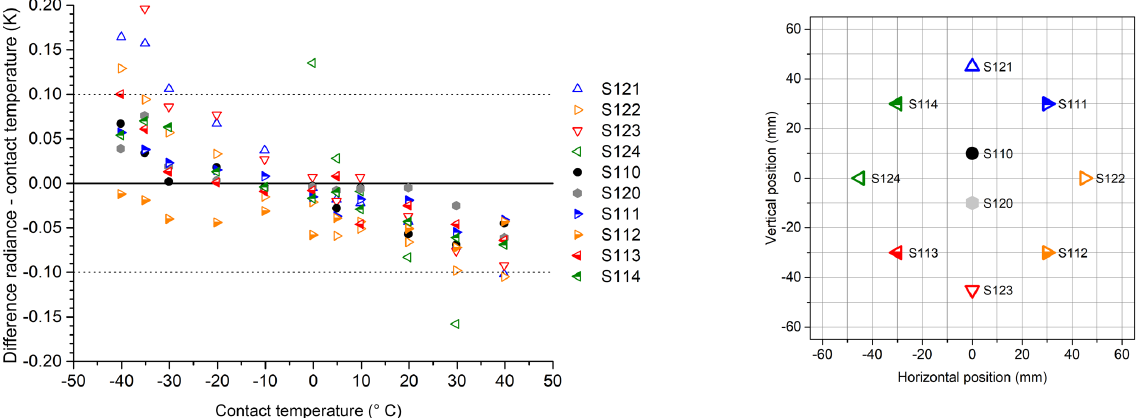
Figure 7. Differences between surface radiance temperatures and temperatures measured with the PT100 sensors (contact temperature) for BB1 at different temperatures. The approximate positions of the sensors under the optical surface are shown on the right.